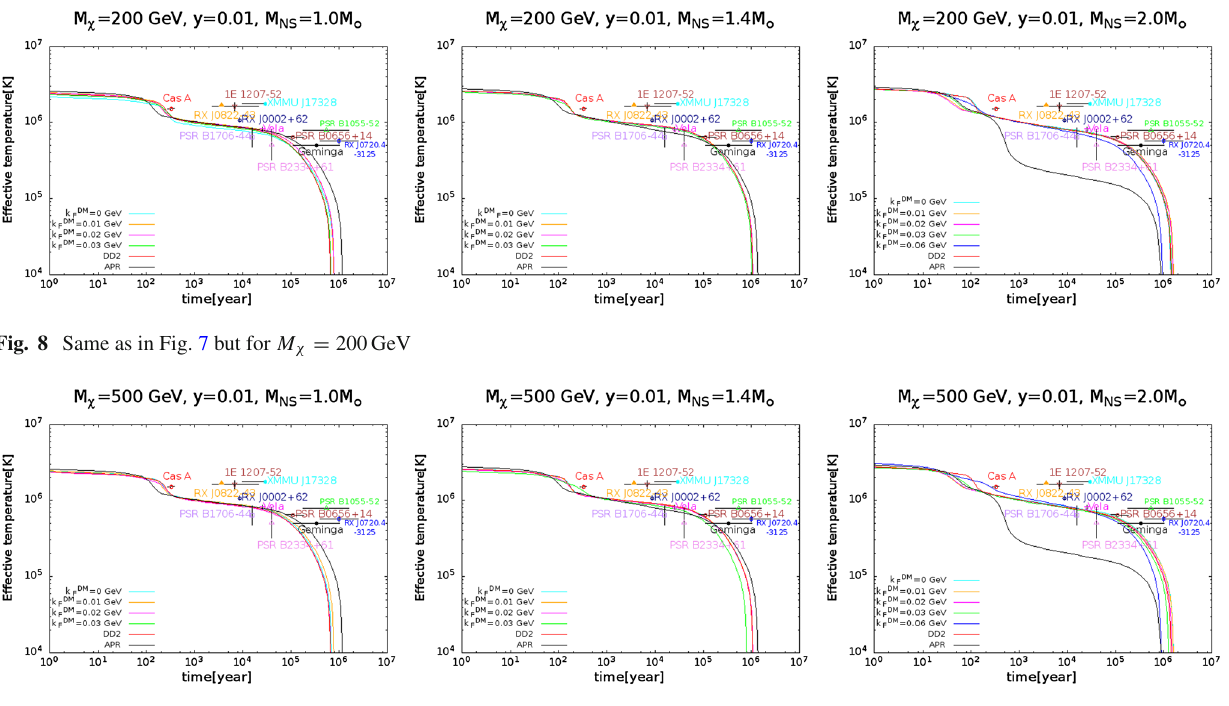
Fig. 9 Same as in Fig. 7 but for M χ =